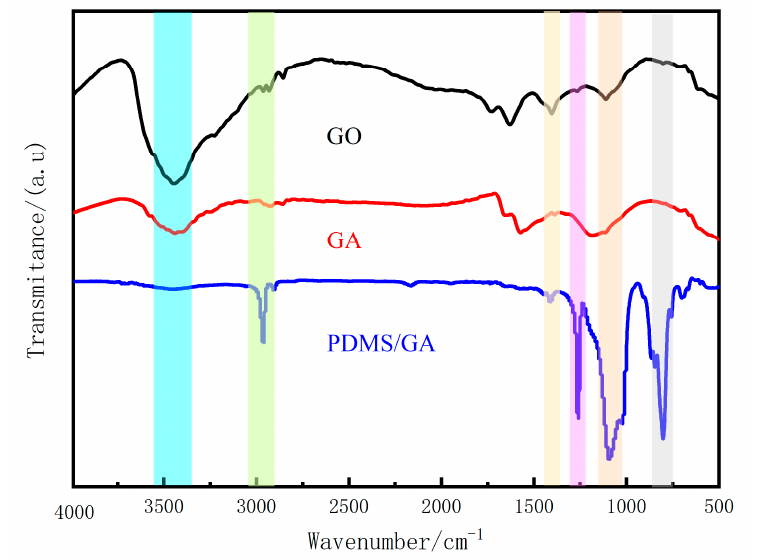
Figure 5. FTIR spectra of raw GO, GA, and PDMS/GA (the shadows from left to right are 3446 cm − 1 , 2963 cm − 1 , 1403 cm − 1 , 1262 cm − 1 , 1092 cm − 1 , and 801 cm − 1 ).